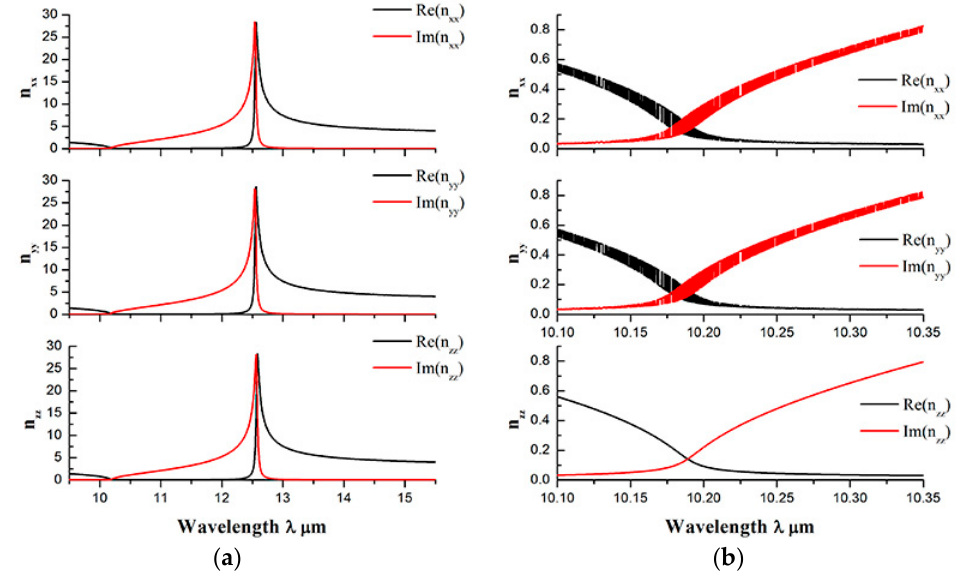
Figure.2 Equivalent refractive index n of SiC under magnetic field ( a ) B = 0 T, ( b ) B = 3 T.